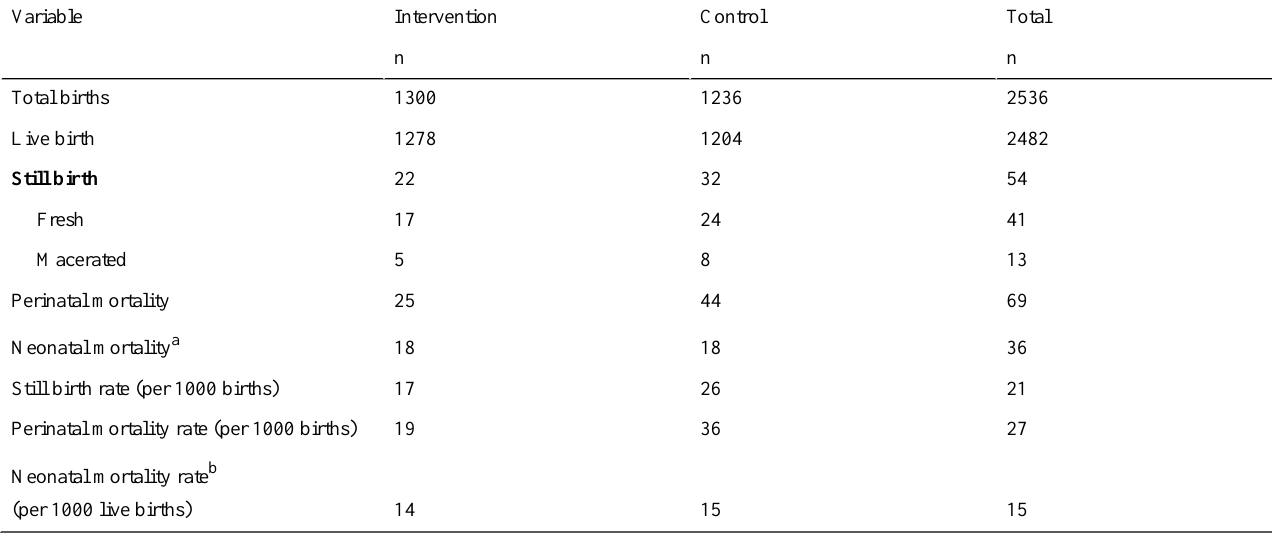
Table 3. Number of births, deaths, and mortality rates.